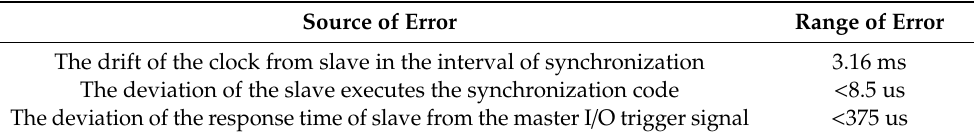
Table 2. The results of synchronous accuracy test (the station is synchronized every 24 h).